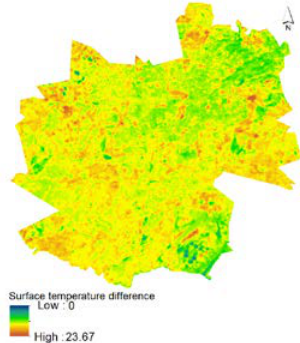
Figure 4: Summer-winter surface temperature difference